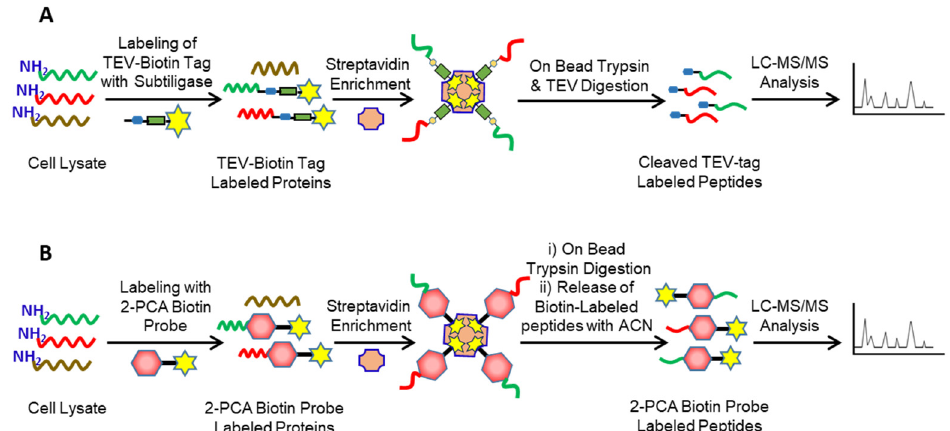
Figure 4. Positive enrichment approaches of N-terminomics. ( A ) In Subtiligase approach, the native or neo-N-terminal peptides labeled with the TEV-biotin probe using Subtiligase enzyme. The labeled peptides are then enriched on avidin beads followed by sequential on-bead trypsin and TEV digestion. LC-MS/MS analysis of probe-labeled native and neo-N-terminal peptides provides the identity of protease substrates and protease cleavage sites. ( B ) In CHOPS, the native or neo-N-terminal peptides are labeled with the 2PCA-biotin tag. The probe-labeled peptides are then enriched on avidin beads followed by on-bead trypsin digestion. After washing, the probe-labeled native and neo-N-terminal peptides are eluted from the beads using acetonitrile. LC-MS/MS analysis of probe-labeled native and neo-N-terminal peptides provides the identity of protease substrates and protease cleavage sites.